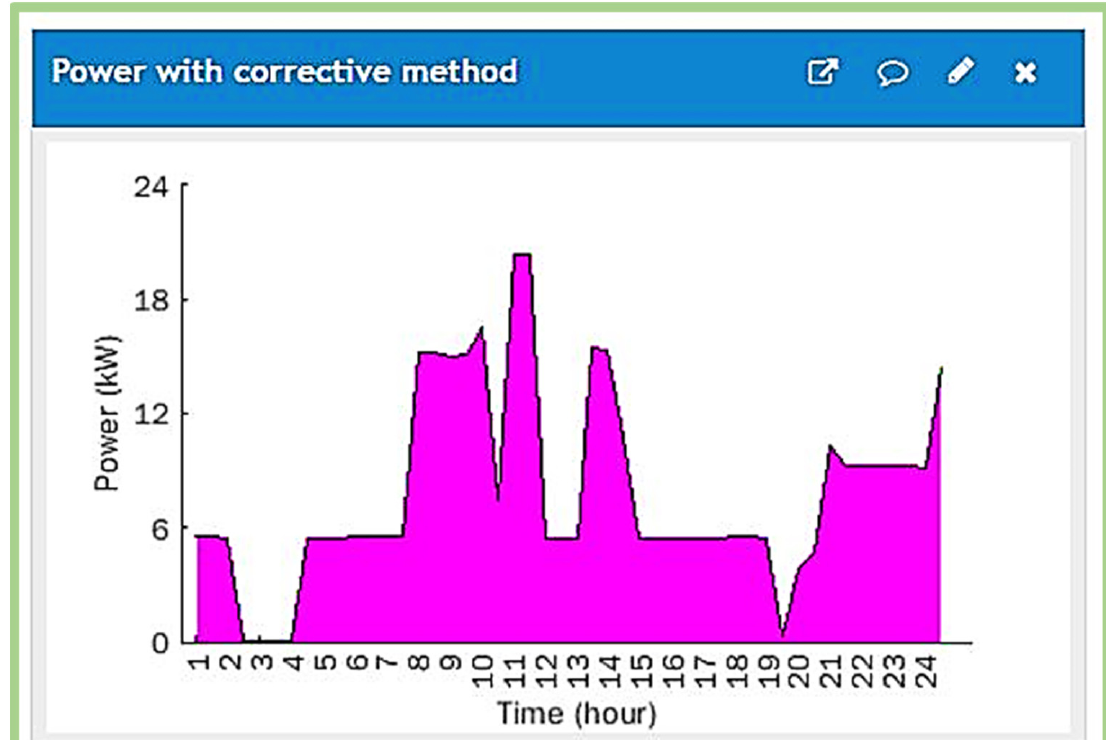
Figure 12. Power GUI of suggested EMS with the corrective method.